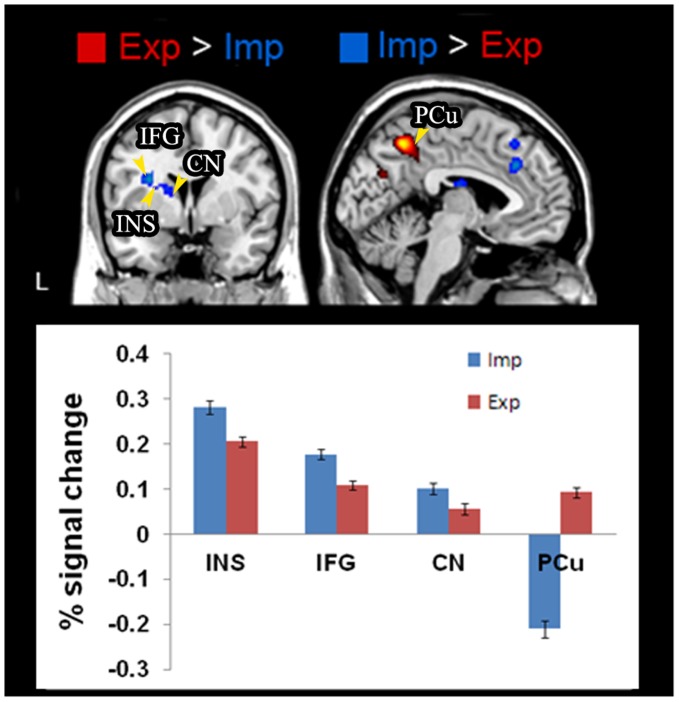
Brain activitions for explicit (Exp) versus implicit (Imp) learners during grammaticality judgment.Four left brain regions showed different blood-oxygenation level dependent (BOLD) signal changes between groups (lower panel): CN = caudate nucleus; IFG = inferior frontal gyrus; INS = insula; PCu = precuneus.